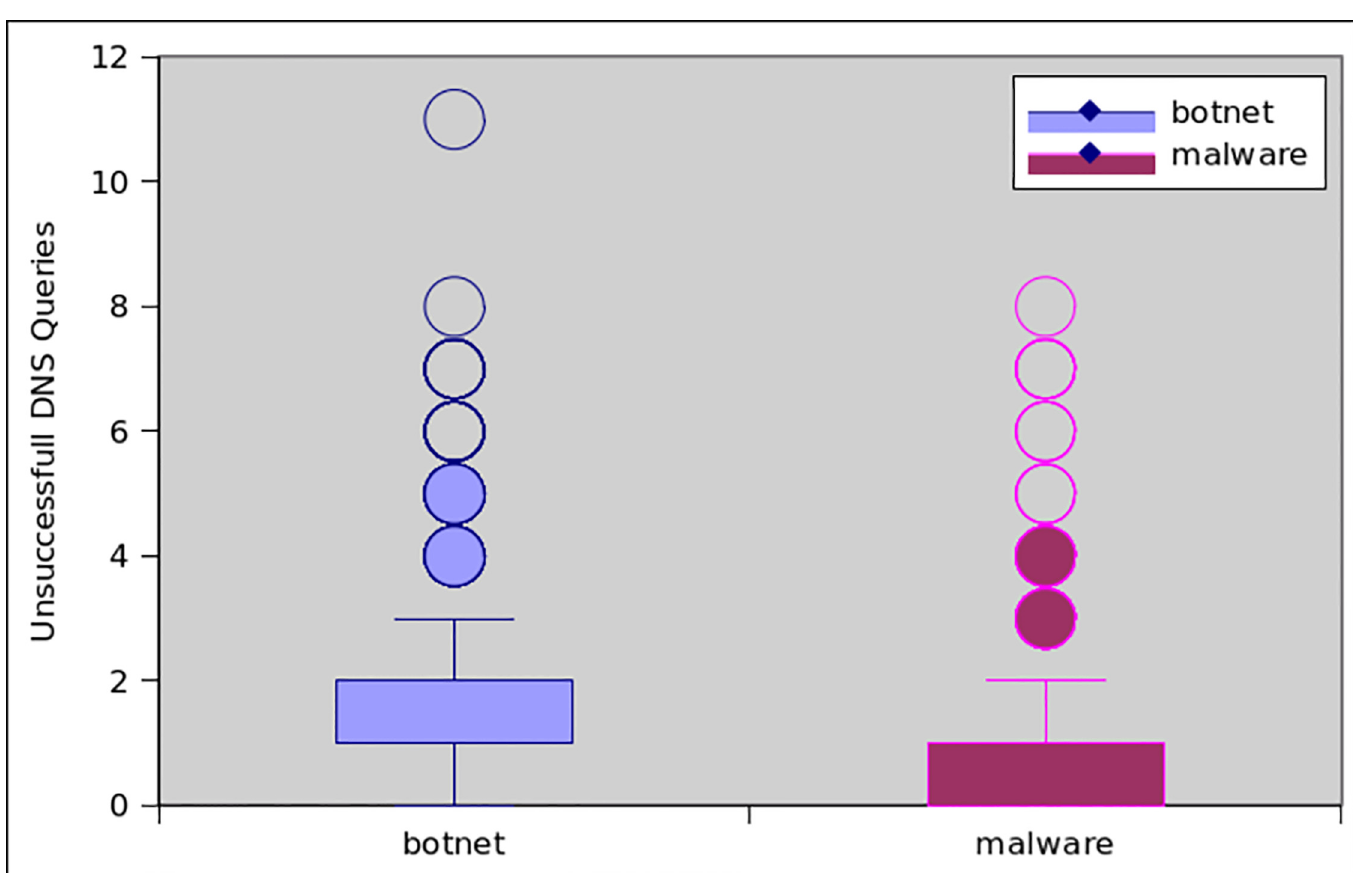
Fig 15. Unsuccessful DNS queries by